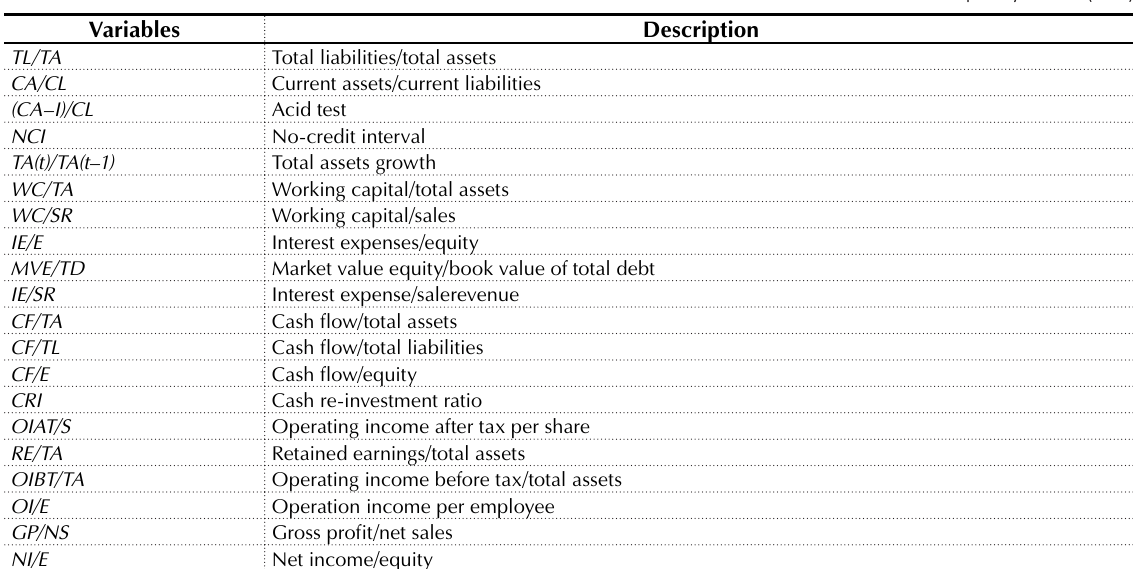
Table A2. List of independent variables – variable set 2